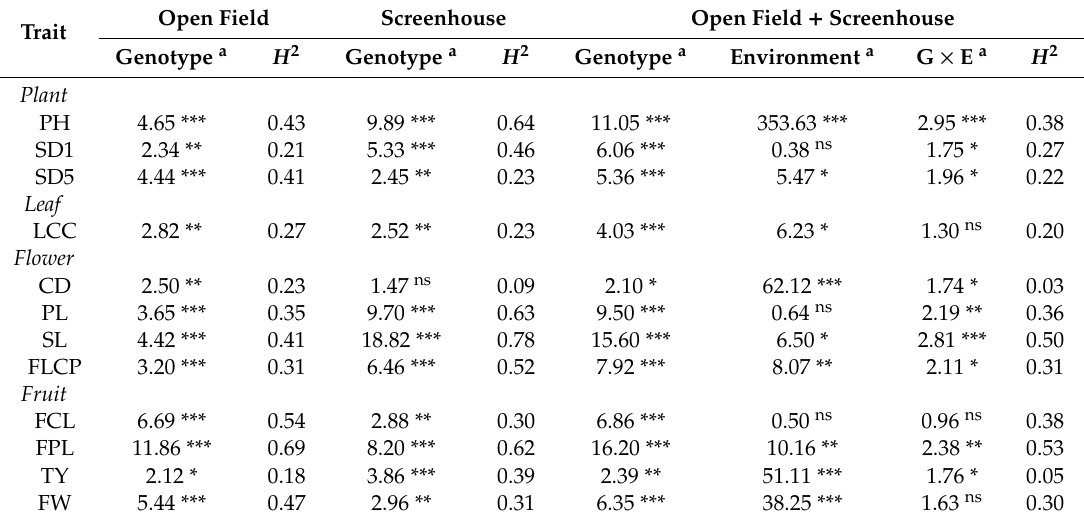
Table 4. F-Values, their probability, and broad-sense heritability values ( H 2 ) obtained for SM and ILs data from the one-way (genotype) analysis of variance (ANOVA) in the open field or screenhouse and from the two-way (genotype, environment, and their interaction G × E) ANOVA by using open field and screenhouse conditions combined: Five traits (SP, LBL, LSS, LPU, and LPL) were excluded from the analysis as they were monomorphic. Open Field Screenhouse Trait